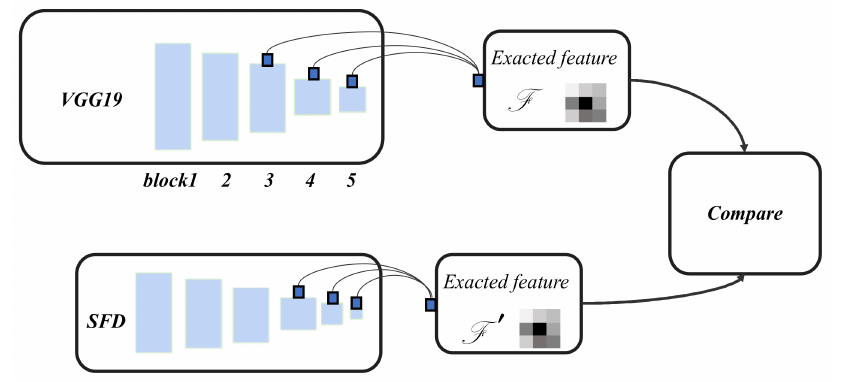
Figure 3. The architecture of the